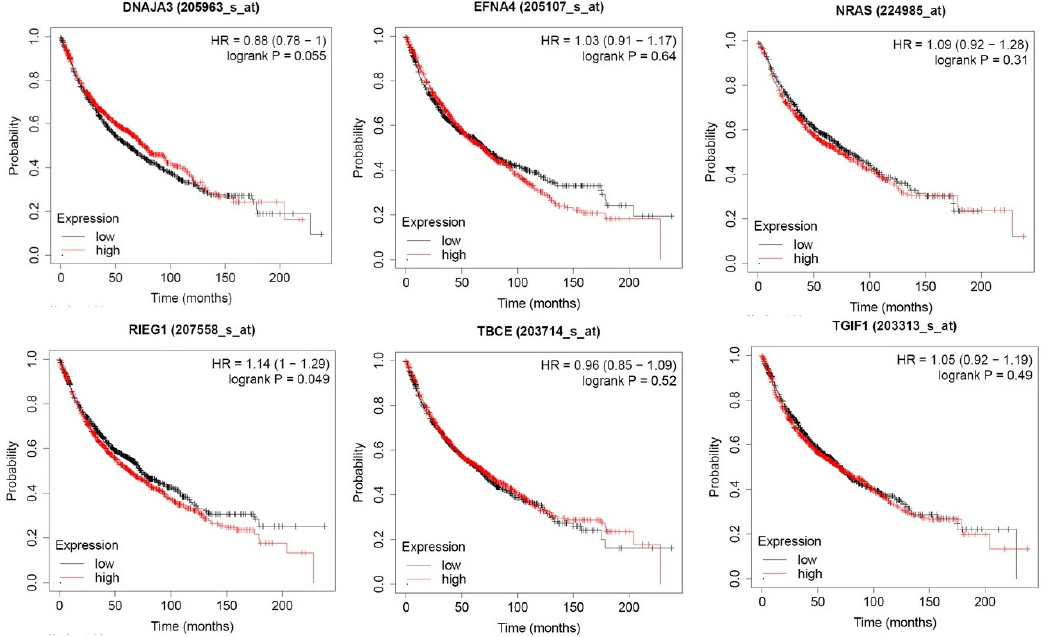
Figure 9. The prognostic value of PTGs in LUAD patients. High expression of PITX2, NRAS, ENFA4, DNAJA3, TBCE, and TGIF1 was correlated with longer overall survival of LUAD patients ( p <